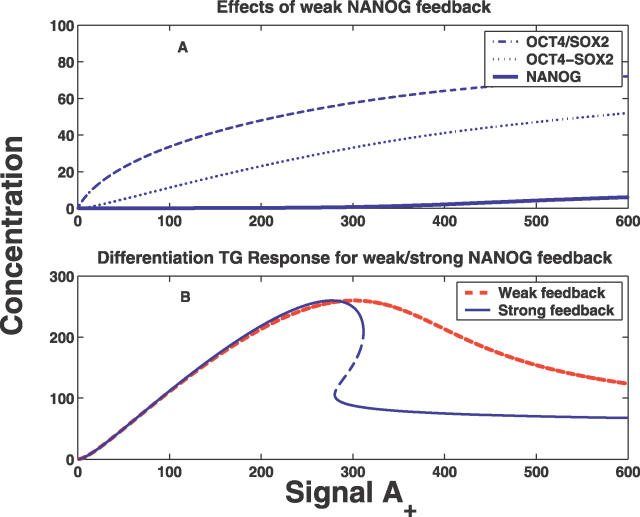
Steady State Values of TG Expression as a Function of the Input Concentration A
+, for the Differentiation and Sel-Renewal Genes for the Case when NANOG Binds Weakly/Strongly to the OCT4 and SOX2 Genes(A) The effects of weak feedback of NANOG to the OCT4 and SOX2 genes. The inefficient binding of NANOG to these genes leads to a loss of the switch-like behavior.(B) The consequence of weak NANOG binding on the TG expression. With weak feedback, the expression level does not fall off sharply as compared with the case with strong feedback, thereby demonstrating that strong feedback is essential to prevent the differentiation TGs from being expressed.